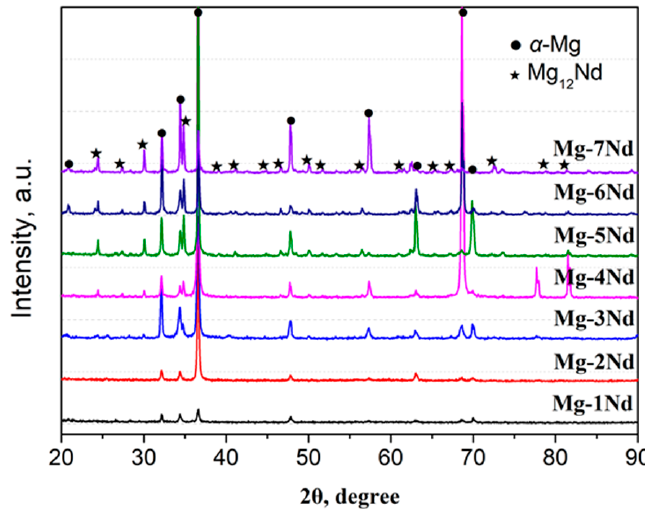
Figure 7. X-ray diffraction patterns of Mg–Nd system alloys.